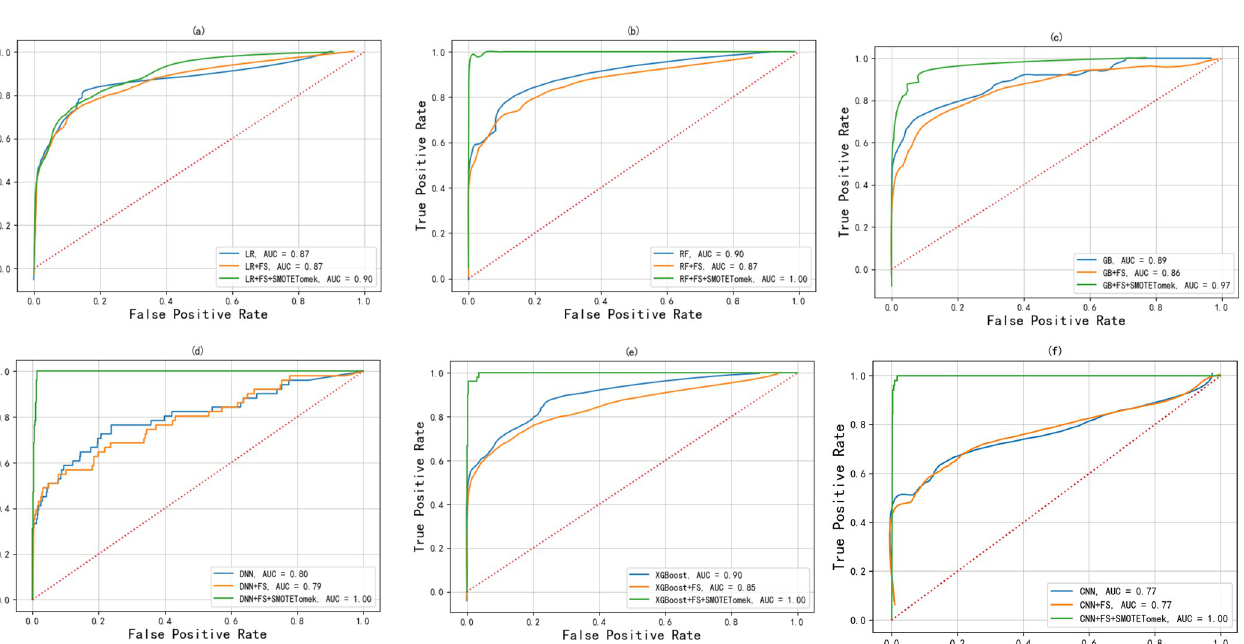
PLOS ONE | https://doi.org/10.1371/journal.pone.0278217 November29,